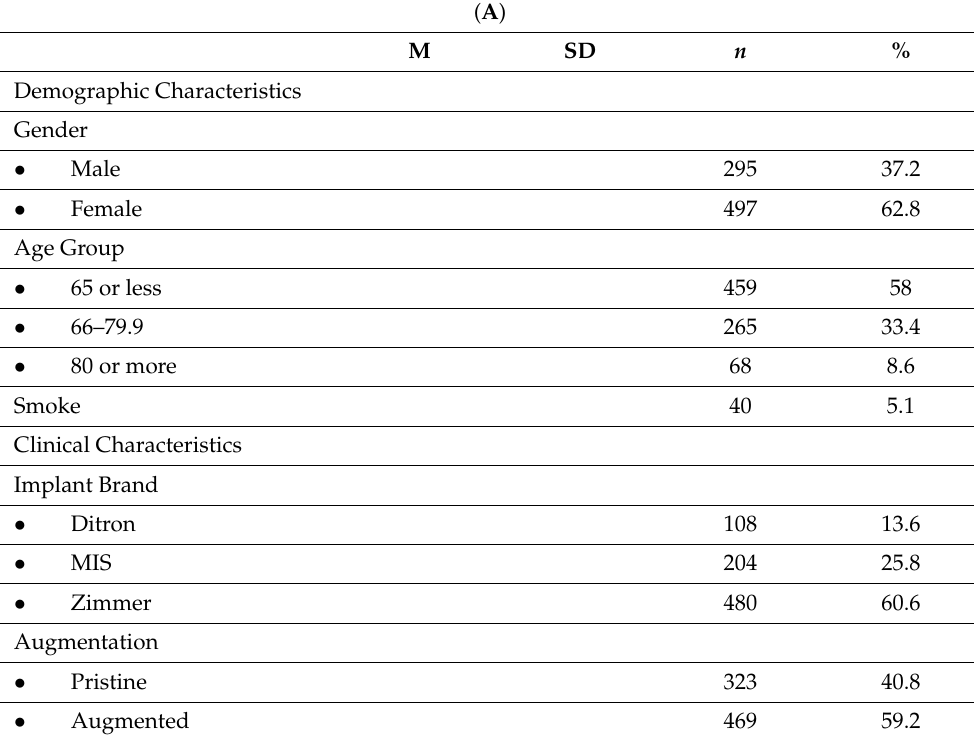
Table 1. ( A ): Demographics and baseline clinical characteristics of the cohort at patient level ( n = 792). ( B ): Demographics and baseline clinical characteristics of the cohort at implant level ( n =